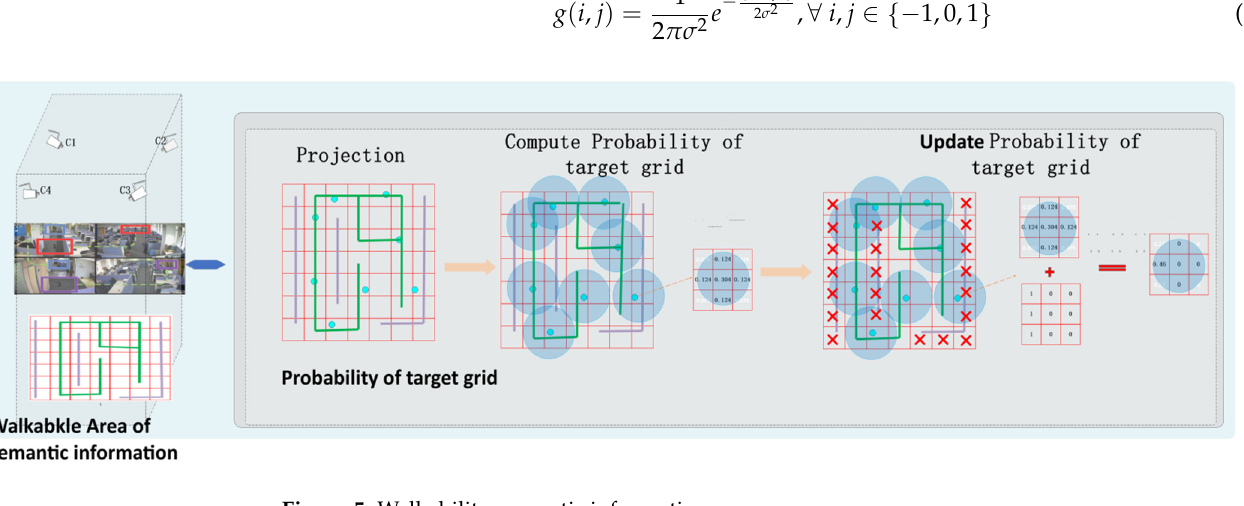
Figure 5. Walkability semantic information.